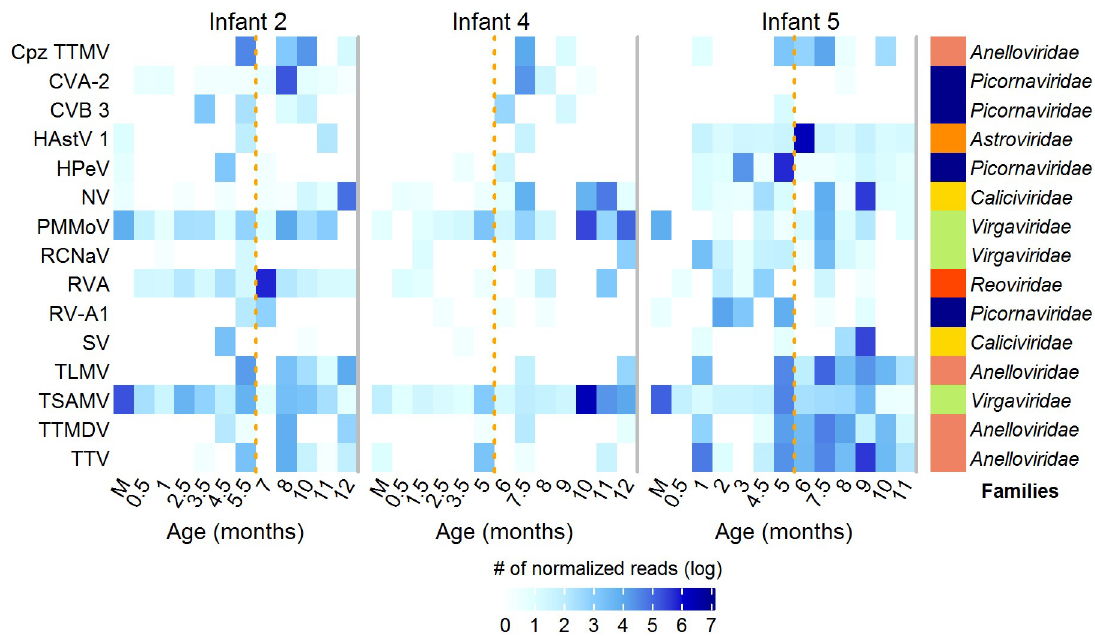
Fig 2. Normalized read abundance of the most abundant and prevalent eukaryotic viral species in infants during the first year of life and their mothers. Samples from infants are indicated according to their age in months and from mothers as M. The family to which each virus species belongs is indicated on the right side. � Cpz TTMV, chimpanzee torque teno mini virus; CVA-2, enterovirus A; CVB 3, enterovirus B; HAstV 1, human astrovirus 1; HPeV, parechovirus A; NV, Norwalk virus; PMMoV, pepper mild mottle virus; RCNaV, rattail cactus necrosis-associated virus; RVA, rotavirus A; RV-A1, rhinovirus A; SV, Sapporo virus; TLMV, TTV-like mini virus; TSAMV, tropical soda apple mosaic virus; TTV, torque teno virus and TTMDV, torque teno midi virus. The discontinuous yellow lines divide the year into